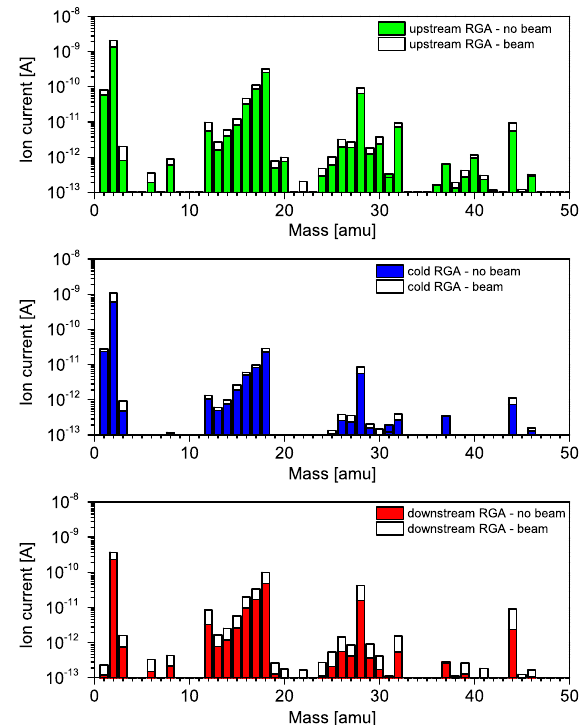
FIG. 16. Mass spectra measured with the three RGAs installed in the upstream, downstream, and cold section of COLDDIAG, with and without beam.